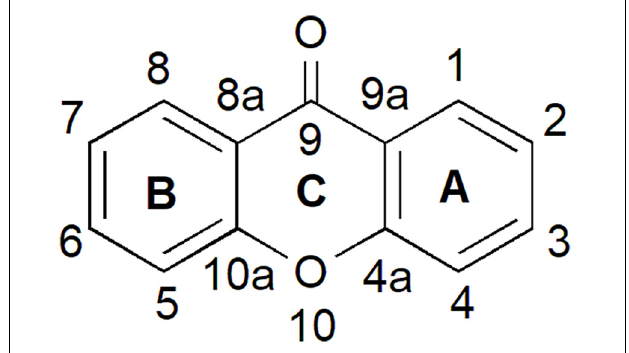
FIGURE 1 | Xanthone is a phenolic compound with a planar dibenzo- γ -pyron scaffold. It contains conjugated aromatic ring system that is composed of two rings; carbons 1–4 (ring A) and carbons 5–8 (ring B) and attached together through an oxygen atom and a carbonyl group (ring C) to form the basic skeleton of xanthone known as